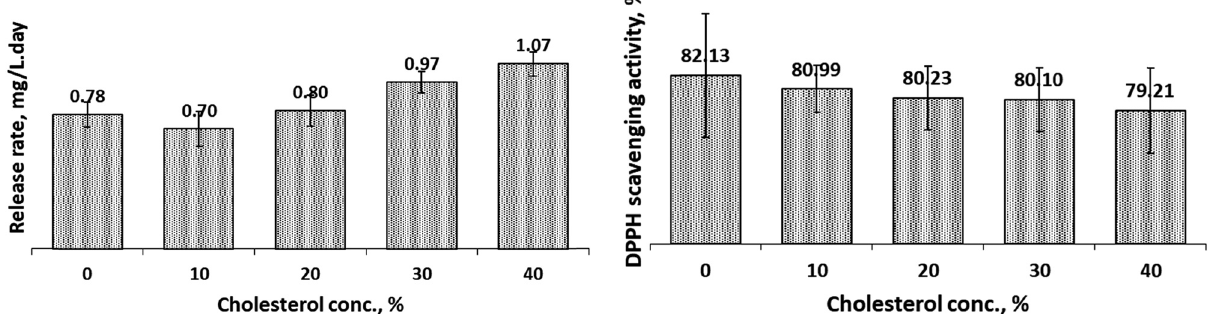
Figure 11: DPPH scavenging activity of CCL in SIF solution as a function of